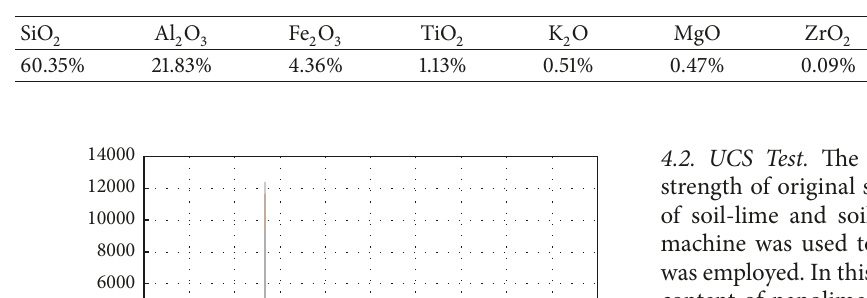
Table 3: Chemical composition of original soil.